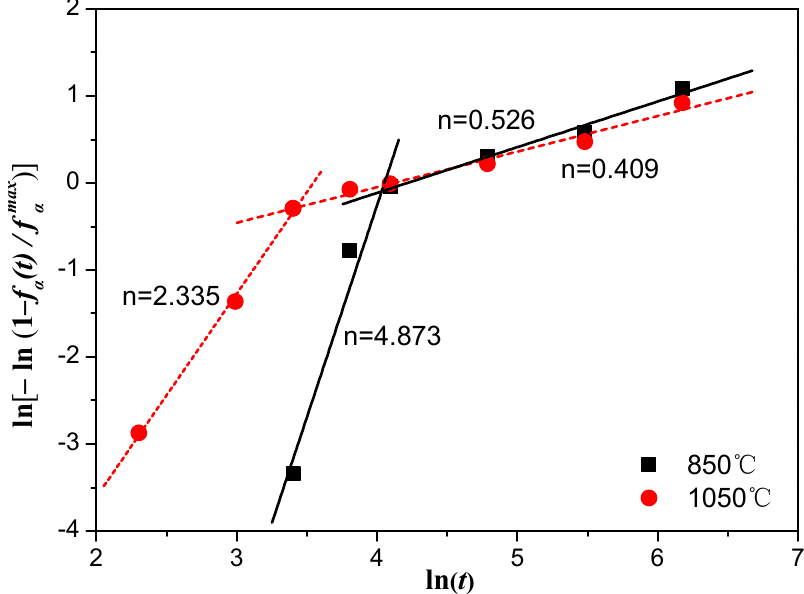
Figure 11. Plot of ln [ − ln (1 − f α ( t ) / f max α )] versus ln ( t ) for Ti–3.5Al–5Mo–4V alloy isothermally aged at 500 °C after being solution-treated at different temperatures.